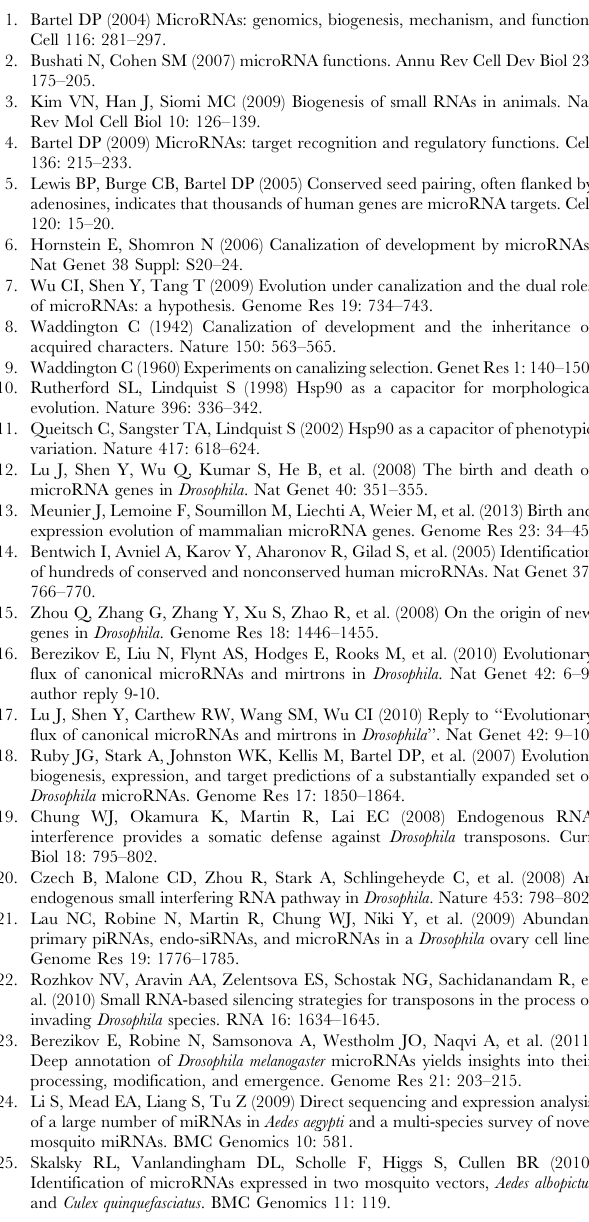
Text S3 The evolution of miR-982s, miR-310s and miR-972s expression.